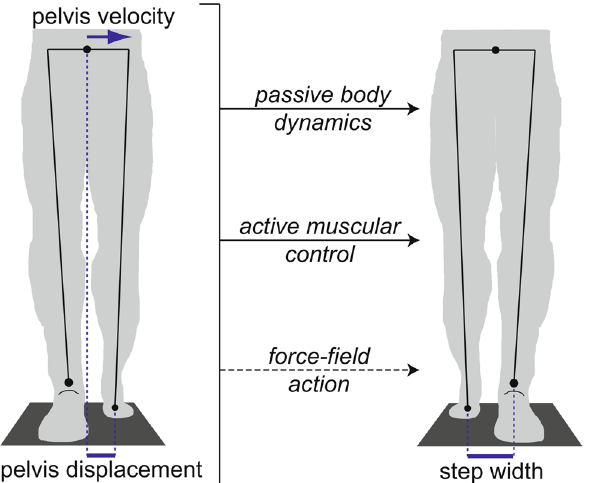
Figure 1. Mediolateral pelvis displacement and velocity at the start of a step (left panel) predict step width at the end of the step (right panel), here illustrated in a frontal plane view of a step with the left foot.